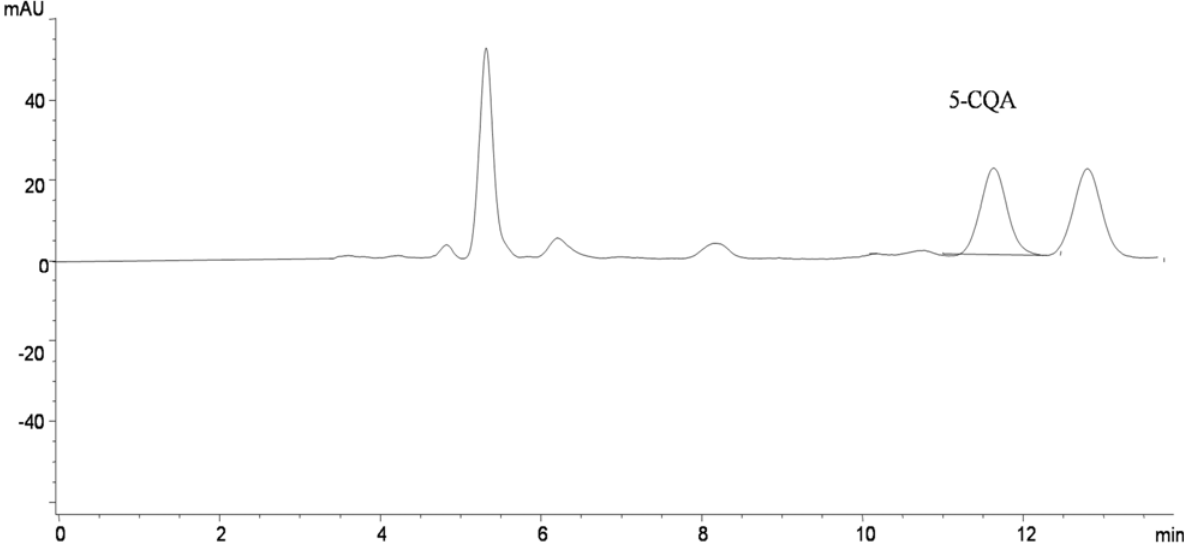
Figure 1. Representative HPLC-DAD chromatogram of mate tea extract obtained by liquid CO extraction with 40% ethanol using pressure of 100 2